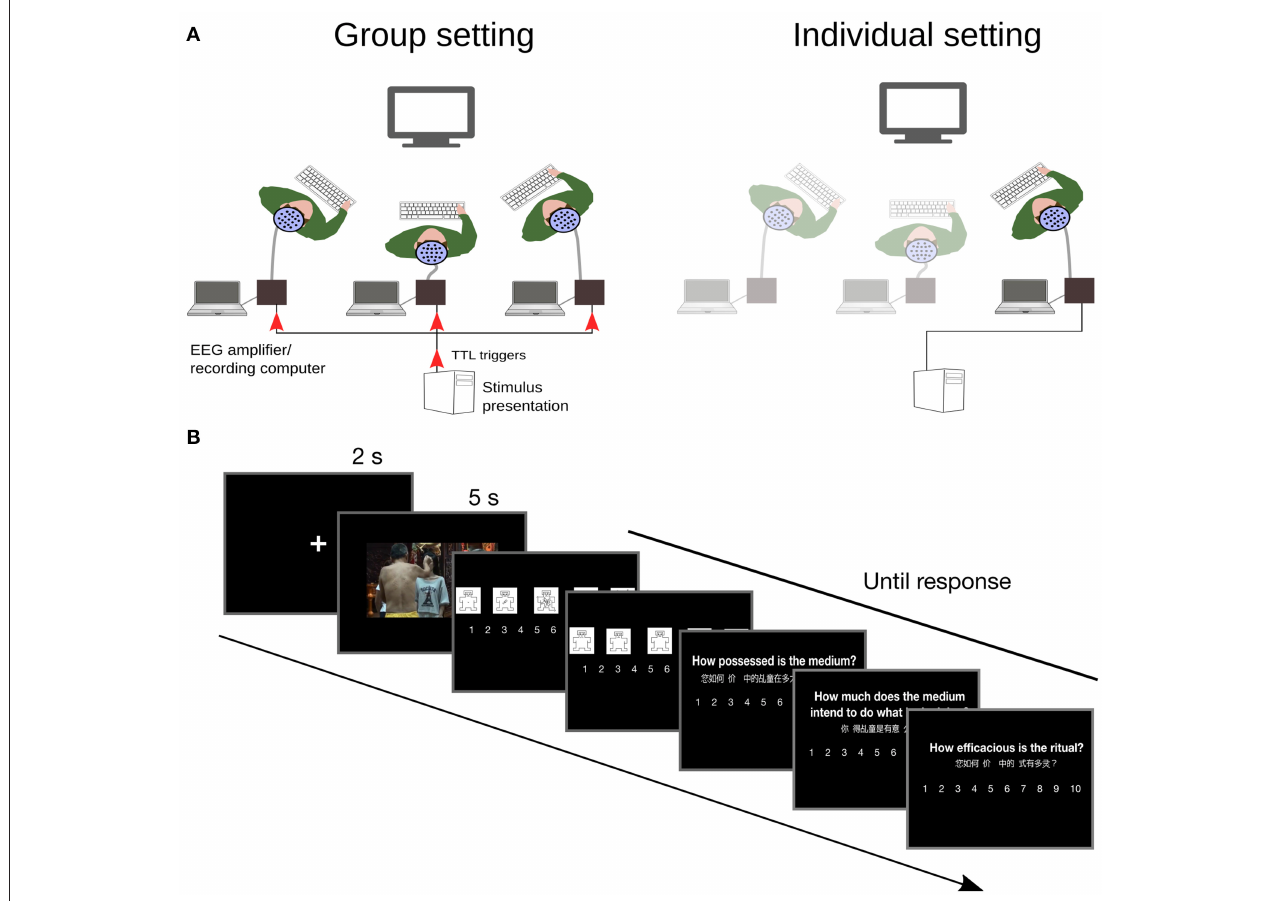
FIGURE 1 | Experimental setup and timeline. (A) Religious believers rated the perceived efficacy of Chinese spirit medium rituals presented in video clips, while electroencephalographic data were recorded. In the group social setting, all participants attended to the same screen. In the individual social setting, participants watched video clips alone. (B) Experimental